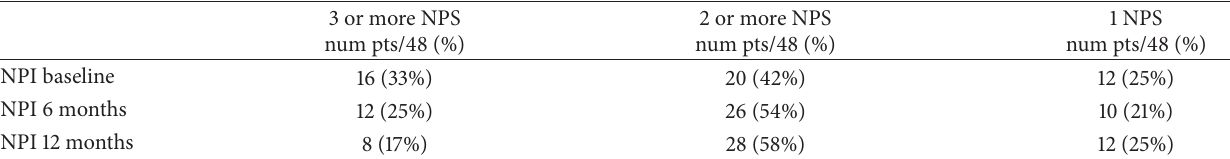
Table 6: A synopsis of the presence of a single or more than one NPS for each patient, during follow-up. 3 or more